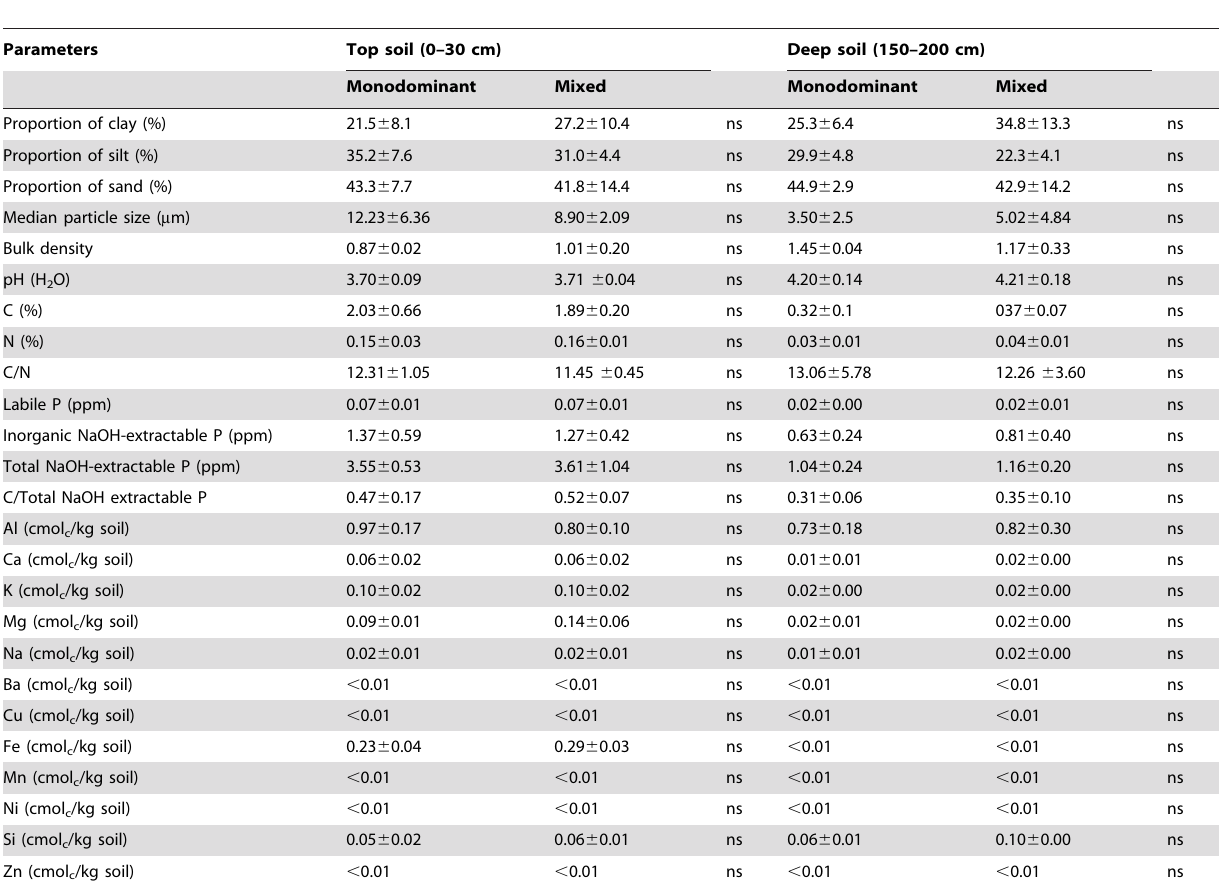
Table 1. Soil physical and chemical characteristics in three 1 ha plots of monodominant Gilbertiodendron forest and three 1 ha plots of mixed forest at Dja Faunal Reserve, Cameroon.